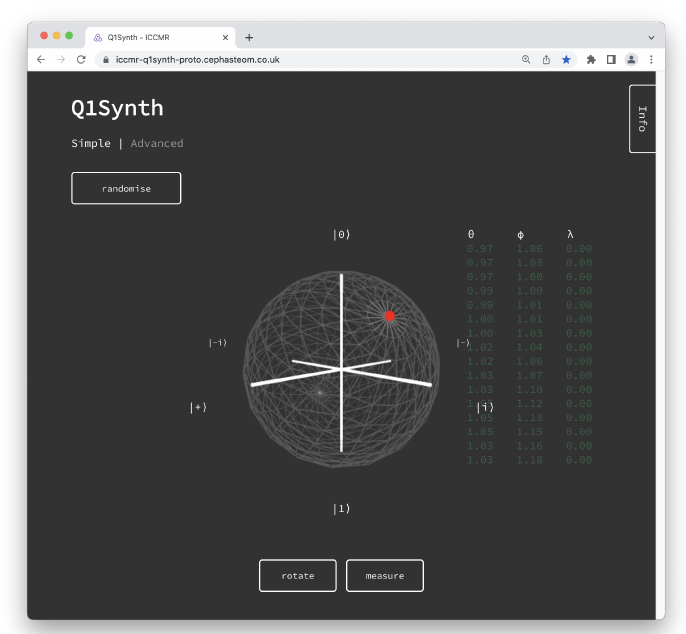
Figure 1. A screenshot of the Q1Synth in ‘Simple’